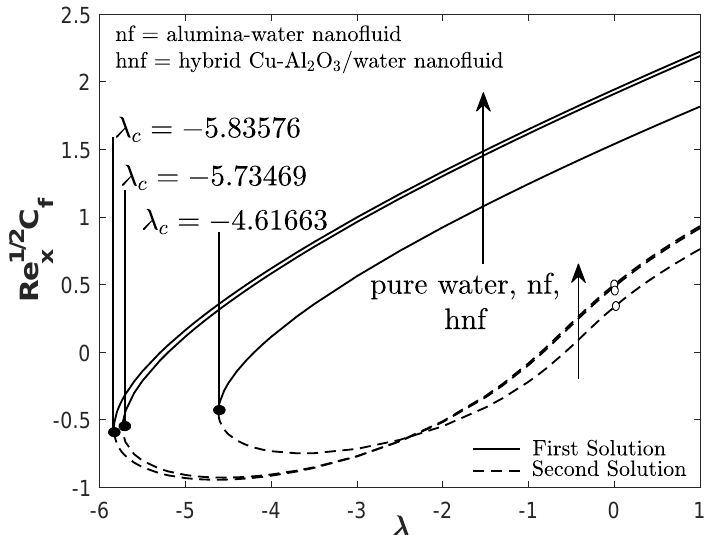
Figure 3. Re x 1/2 C f towards λ for hybrid nanofluid ( φ 1 = 0.1, φ 2 = 0.005 ) , alumina-water nanofluid = 0.1, φ = 0 ) , and pure water ( φ ( φ 2 1